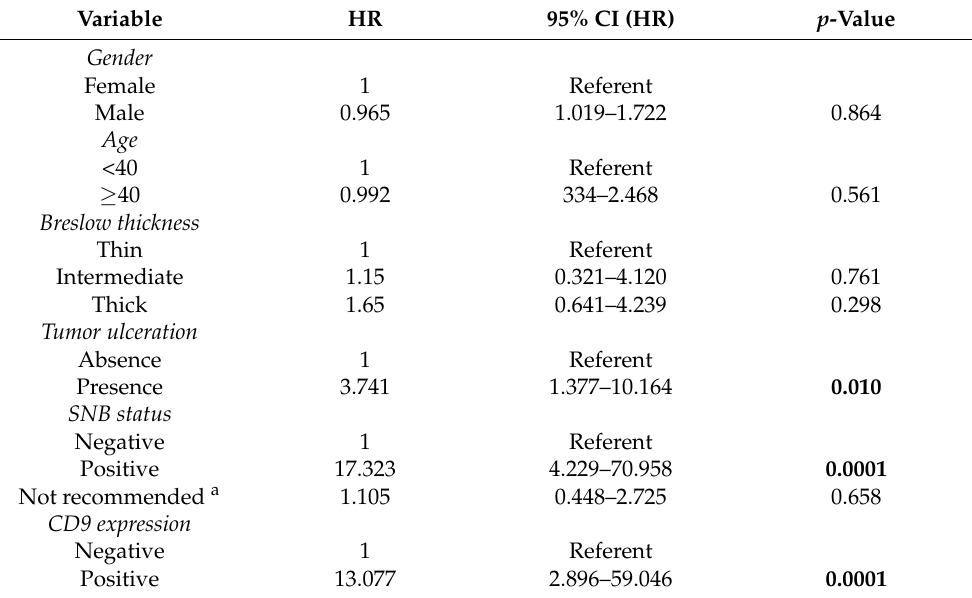
Table 3. Multivariate Cox regression associated with melanoma specific survival